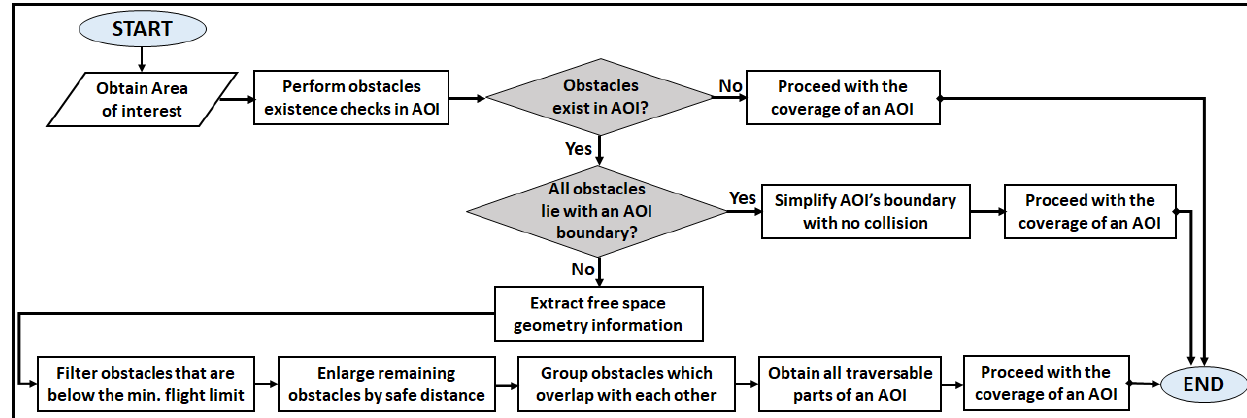
Figure 5. Flowchart of multi-criteria-based free spaces geometry information extraction